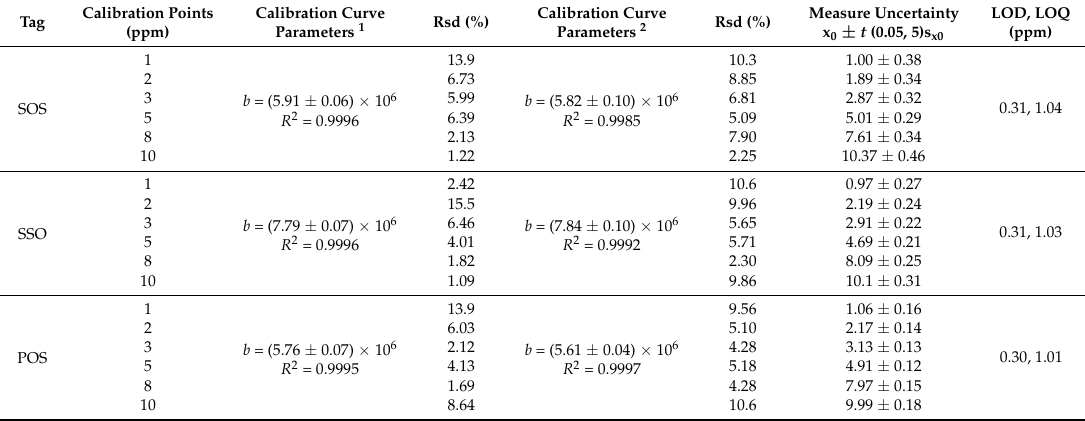
Validation data: calibration curve parameters, repeatability, reproducibility, uncertainty measure, limit of detection (LOQ) and limit of quantification